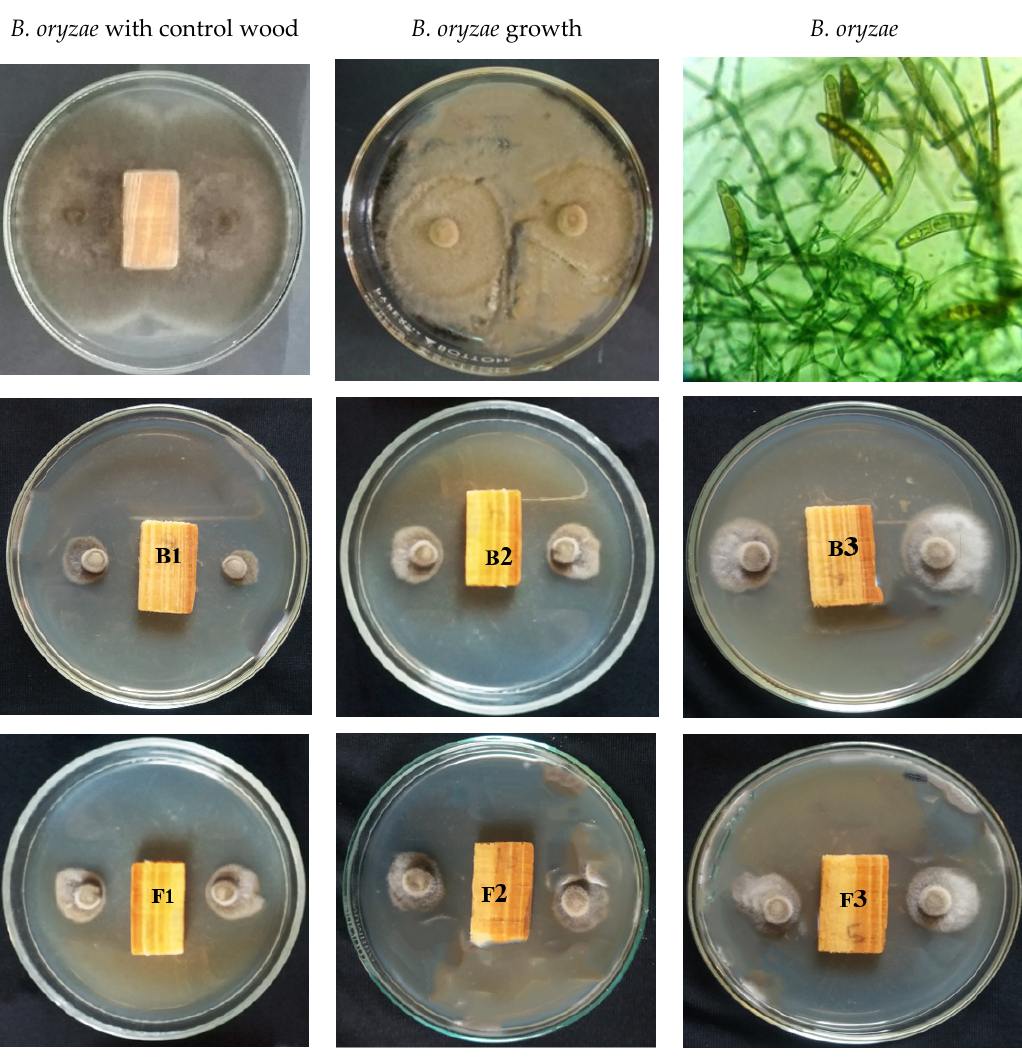
Figure 1. Antifungal bioassay of wood treated with (B) P. halepensis oily liquid extract (OLE) and (F) S. terebinthifolius essential oil (EO) against the growth of B. oryzae . B1: 3%; B2: 2%; B3: 1%; F1: 3%; F2: 2%; F3: